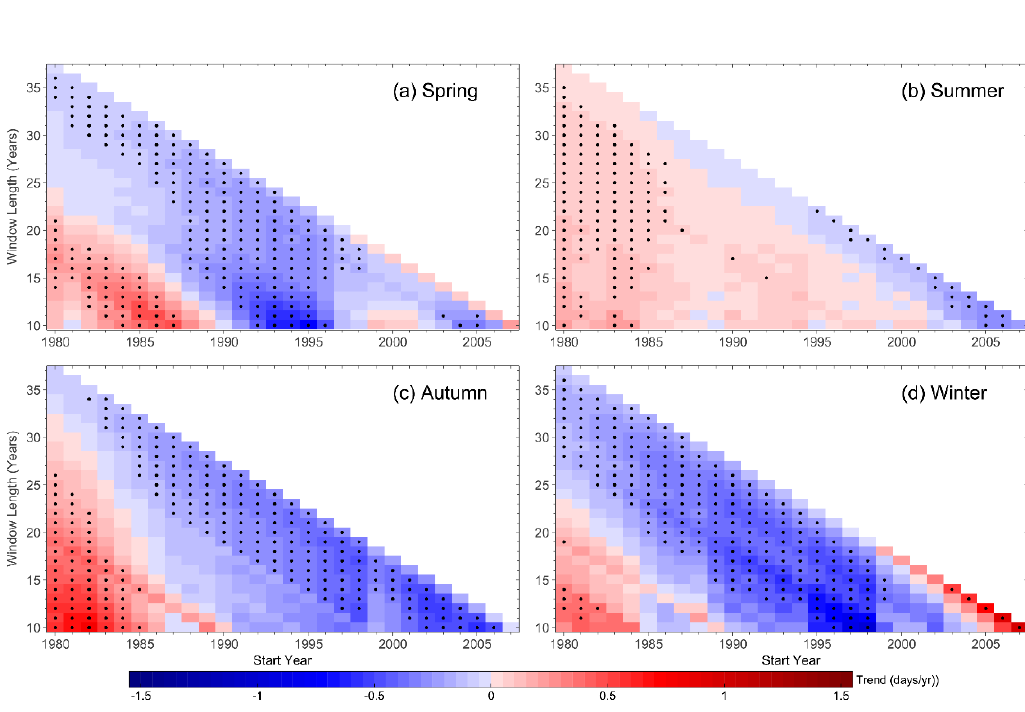
Figure 8. The running trend analysis for annual mean HDs at all stations starting from 1980 to 2007 and ending in 2016, with at least 10-year span required to calculate the trend. The x axis and y axis indicate the start year and the length of the time series to calculate trend, respectively. The color of rectangle represents the intensity of the trend, and those with black dots mean trends above 95% significance level.